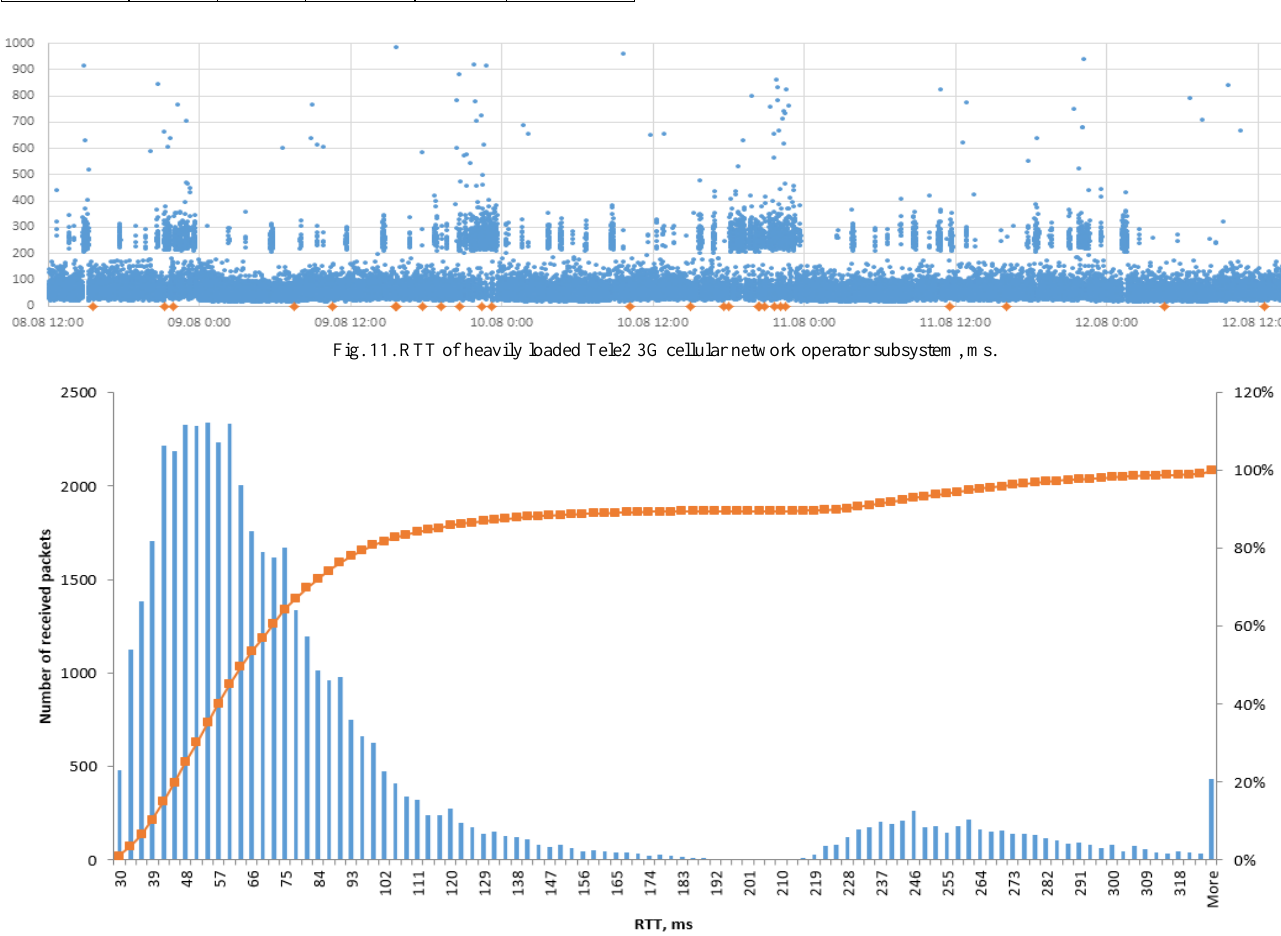
Fig. 12. RTT distribution in heavily loaded Tele2 3G cellular network operator subsystem.